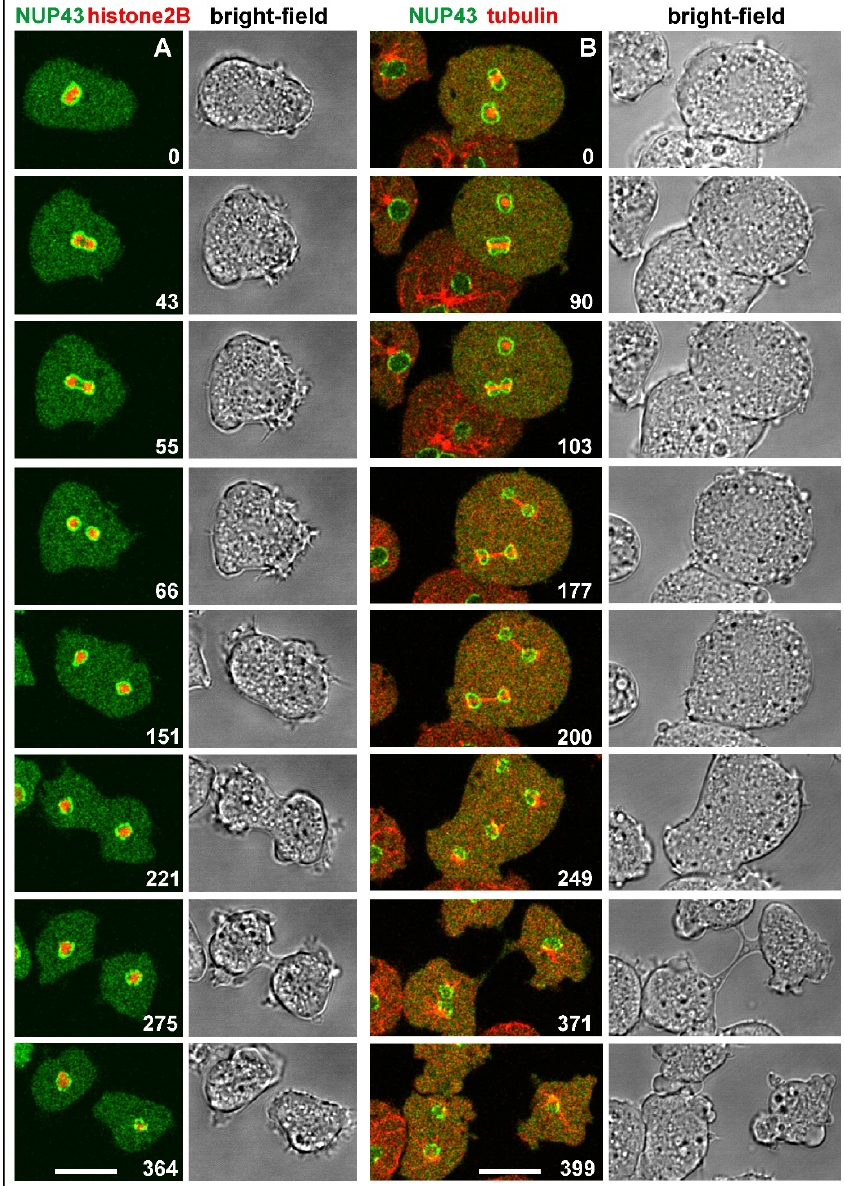
Figure 2. Normal mitosis of cells showing persistence of the inner nuclear membrane. ( A ), a cell expressing NUP43-GFP to label the nuclear membrane (green) and mRFP-histone2B to visualize the chromosomes (red), which remain enveloped thoughout mitosis. ( B ), a binucleate cell expressing NUP43-GFP (green), and mRFP- α -tubulin (red) to label centrosomes and spindles. Ingression of the cleavage furrow commences after disruption of the spindle (249-s to 371-s frames). The cell divides into three daughter cells, two uninucleate ones, and a binucleate one. An interphase cell on the left shows, for comparison, the centrosome attached to the nuclear membrane, microtubules in the cytoplasmic space but no tubulin within the nucleus. The cells were slightly compressed by agar overlay. Time is indicated in seconds. Bars, 10 µm.